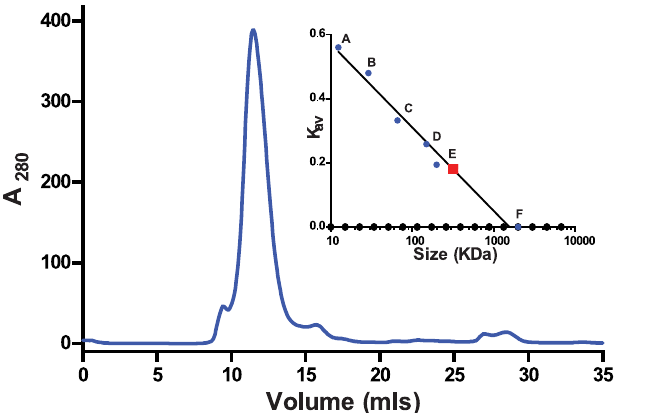
Fig 7. Size-exclusion chromatography of concentrated metal-affinity chromatography-purified PelB-VPU. Eluate from Fig 6 was subjectedto SEC-FPLC. Sec resin: Superdex200 10/300GL; Flow-rate: 0.5 mL/min, Runningbuffer: 20 mM HEPES, pH 7.5, 250 mM NaCl, 5% glycerol and 0.02% β DDM. The minor peak at 8 mL corresponded to the void volume, and the major peak at 11.48 mL containedPelB-Vpu. The column was calibratedwith cytochrome c (A), carbonic anhydrase (B), albumin(C), alcoholdehydrogenase (D), β -amylase(E) and blue dextran (F) and a standard curve was obtainedas shown in the inset. The size of the Pel-B-Vpu- β DDM complexwas estimated to be 315 kDa.